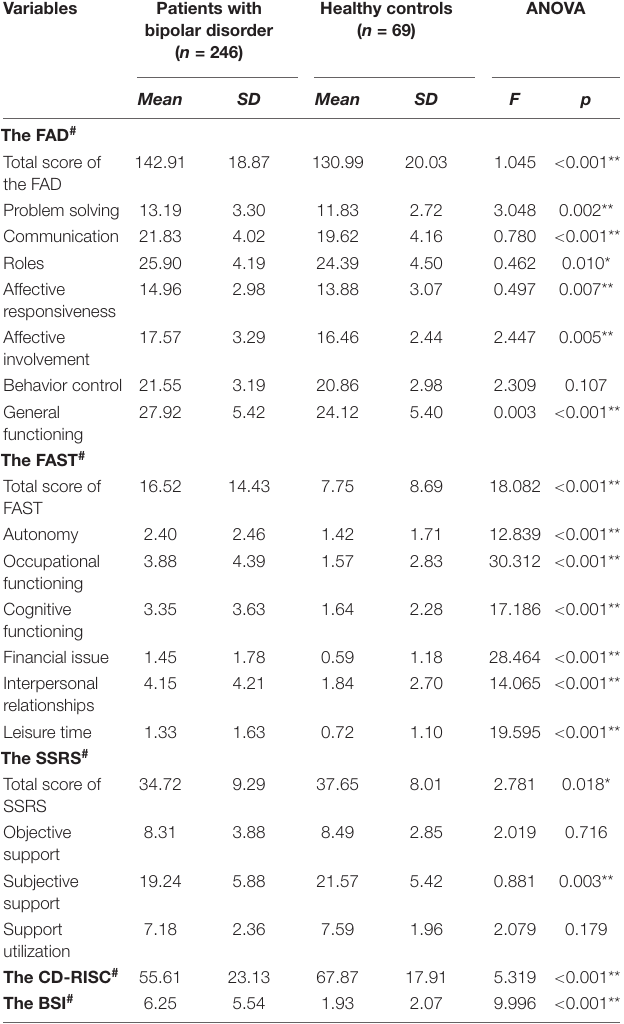
TABLE 2 | Comparisons on the family functioning, psychosocial functioning, social support, resilience and suicidal ideation between patients with bipolar disorder and healthy